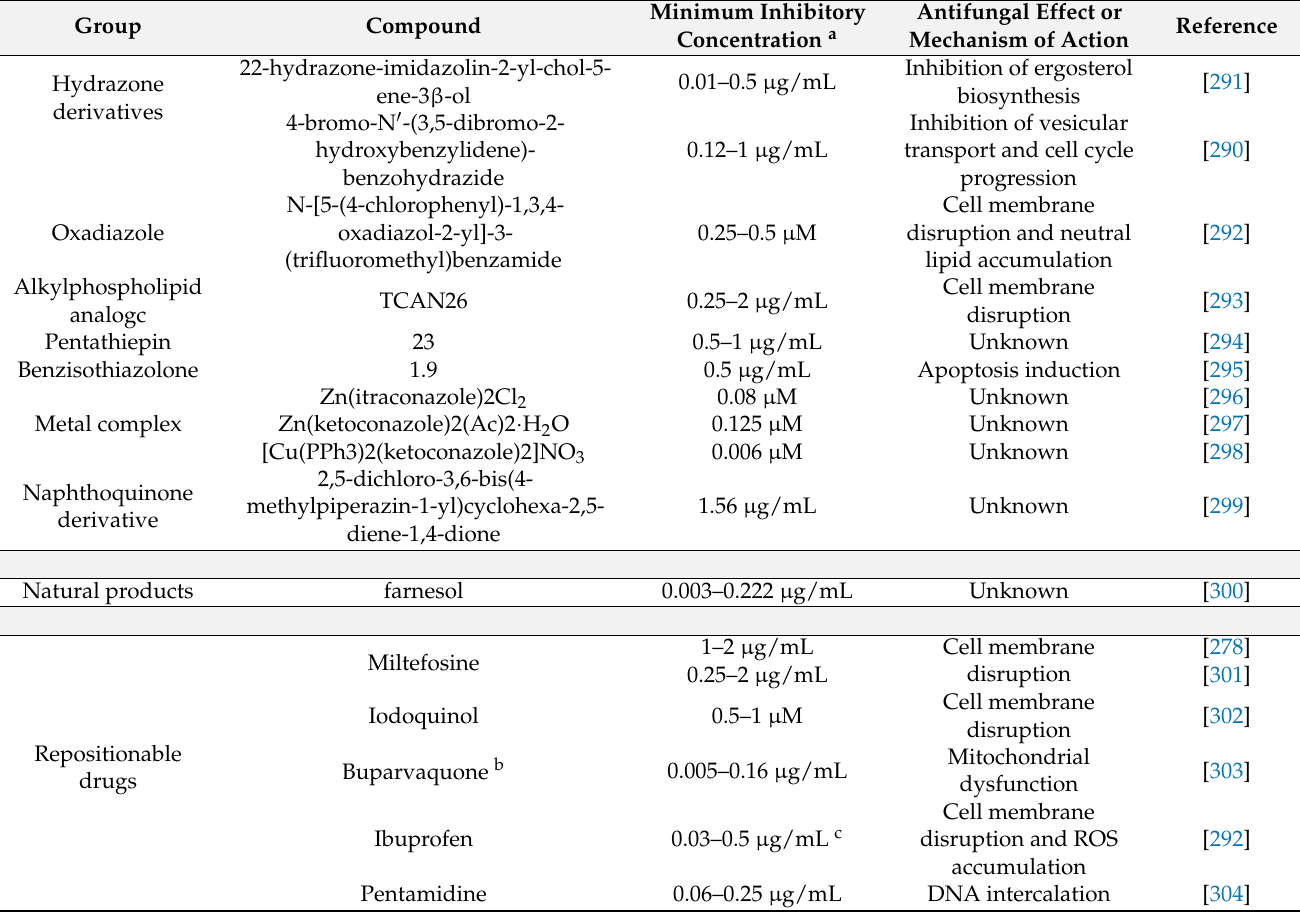
Table 2. New compounds, natural products, and repositionable drugs exhibited promising activity against Sporothrix spp. in the last ten